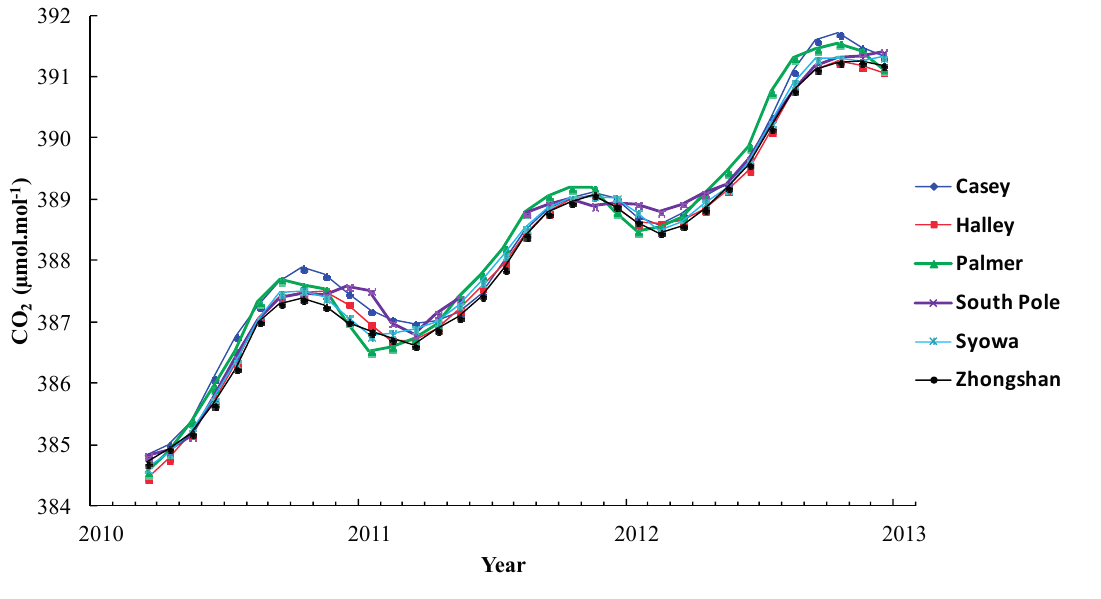
mole fraction (µmol·mol − 1 ; upper) and its increase at each 2